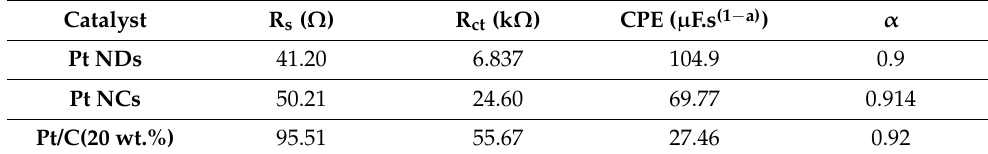
Table 1. Analysis of EIS measured in 0.1 M HClO 4